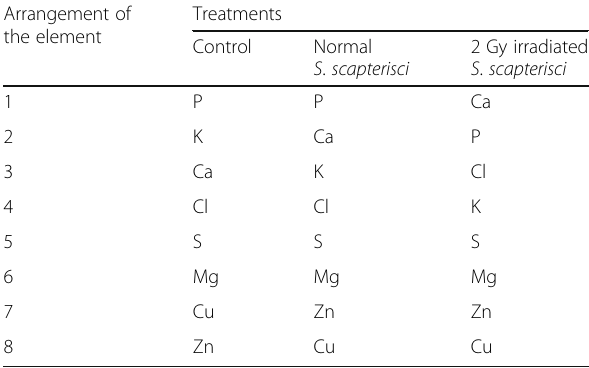
Table 5 Arrangement of the elements according to their concentrations in the whole body tissue of C. pipiens larvae treated with normal and 2 Gy gamma irradiated S. scapterisci Arrangement of the